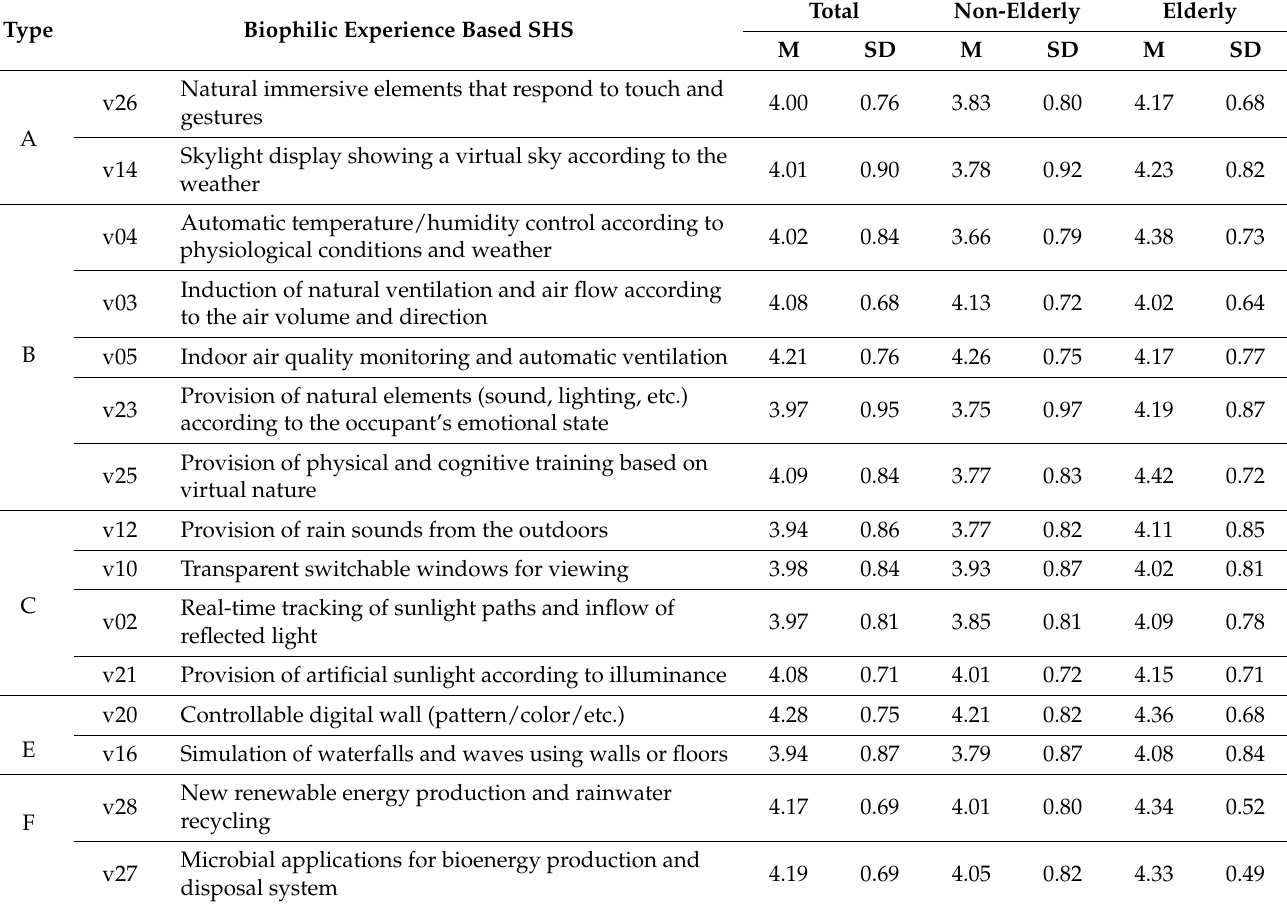
Table 7. Biophilic experience based SHS considering the preferred